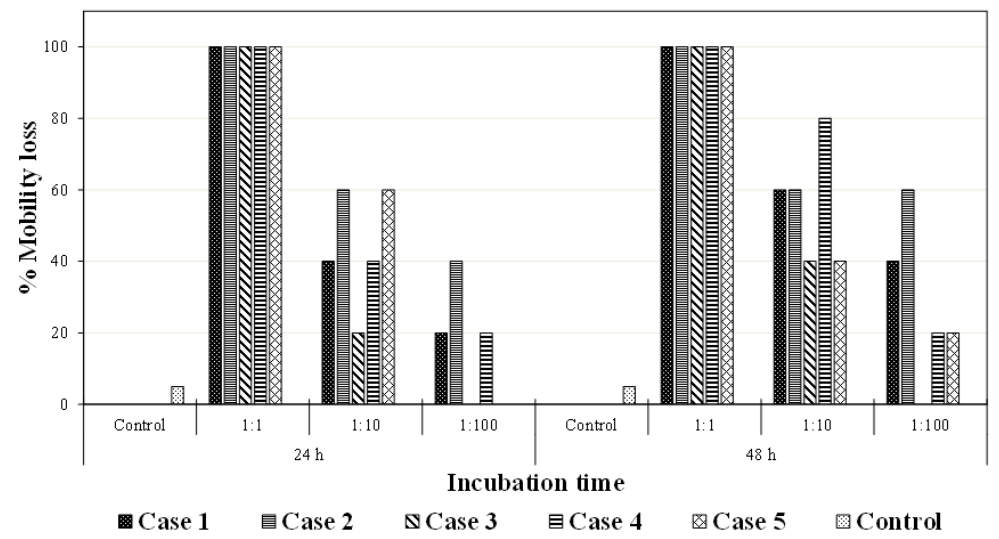
Figure 5. Mobility loss of Daphnia magna crustaceans in the ecotoxicity test. Case 1: surface water and bovine liver catalase. Case 2: DP—10 min. Case 3: DP—20 min. Case 4: 15 mg dm − 3 H 2 O 2 pollutants—20 min. Case 5: 15 mg dm − 3 H 2 O 2 —20 min. Control: raw SW.